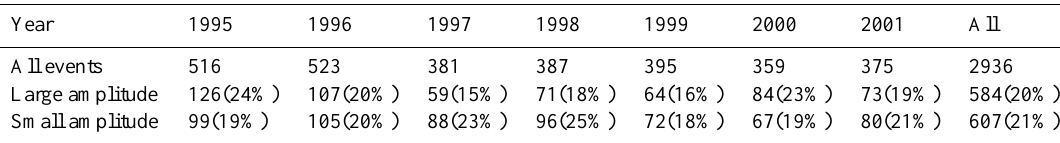
Table 1. Number of transient